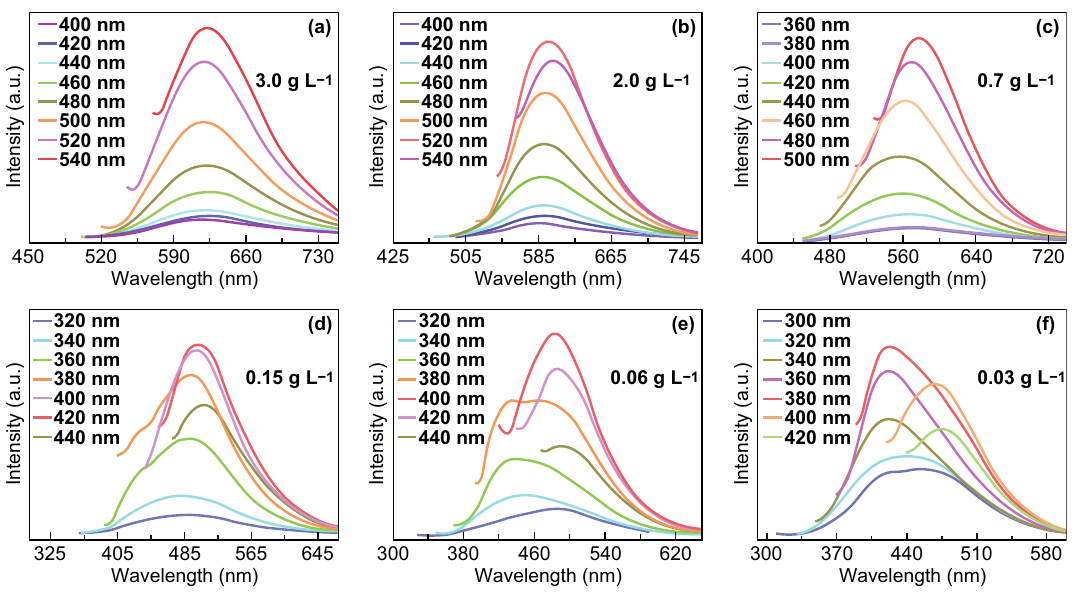
Fig. 7 PL emission peak blue-shifting as the concentration was reduced from 3.0 to 0.03 g L - 1 [77]. Copyright (cid:2) 2017 The Royal Society of Chemistry. (Color figure